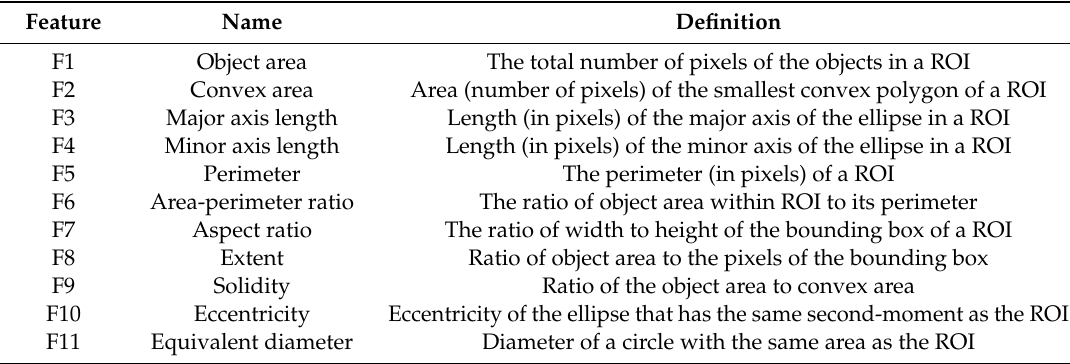
Table 2. Image features used to segment individual cotton seedlings.